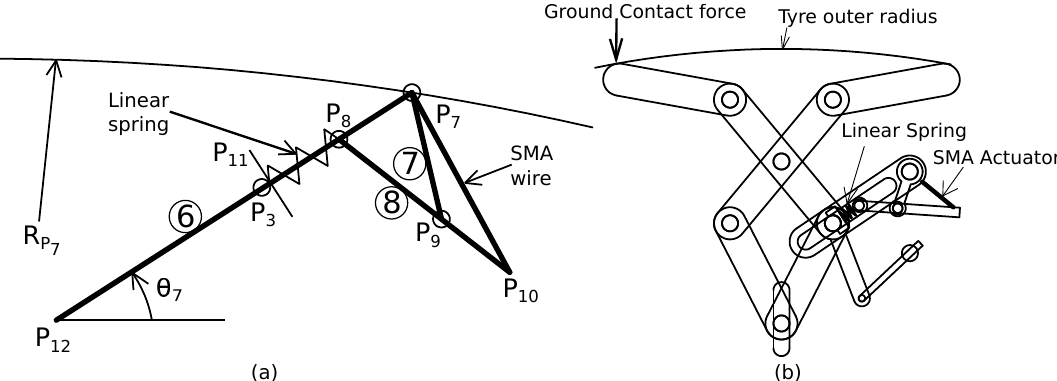
Figure 10. ( a ) Schematic view of chain 3; ( b ) situation when the ground force pushes the mechanism to a closed position but the actuator in an open